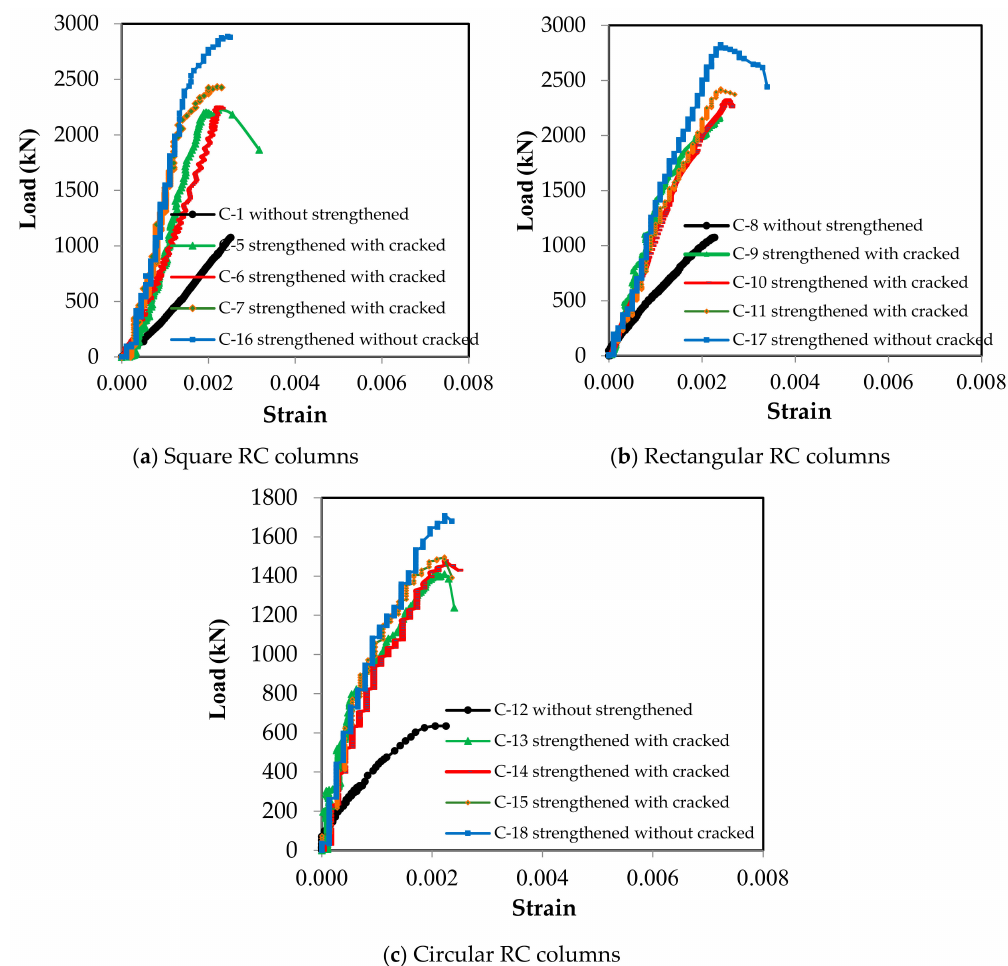
Figure 10. Load–longitudinal steel strain relationships for the RC